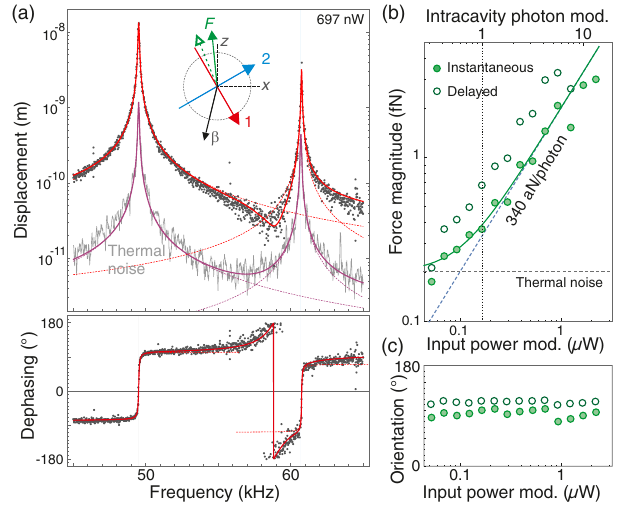
FIG. 9. Delayed photothermal forces. We add the delayed optical forces, of photothermal origin, to Fig. 3. The open symbols represent the magnitudes and orientations of the delayed force vectors, at the measurement position, for increasing modulation depth. The solid symbols represent the instantaneous optical